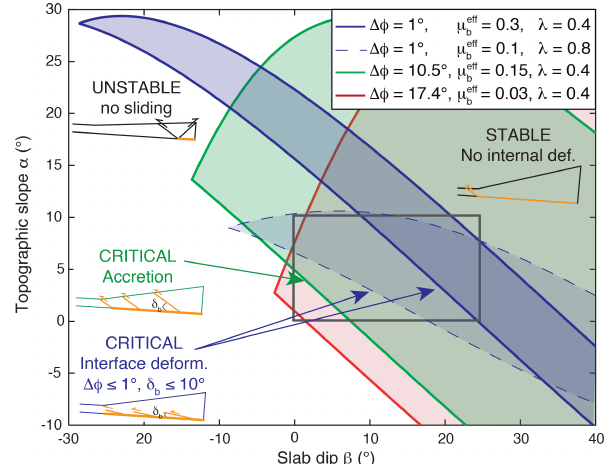
Figure 2. Critical taper theory with different mechanical states. The gray rectangle represents the standard range of topographic slope α and slab dip β of subduction zones. With extremely low effec- tive friction along the megathrust (red curve), the wedge systemat- ically falls in the stable domain. With larger effective friction, and large difference of effective friction between the megathrust and the wedge (green curve), the wedge can reach the accretionary criti- cal state characterized by internal faulting. With a reduced differ- ence (blue curves), a wedge can still reach the critical state but the dip of internal faults within the wedge will decrease and become parallel to the plate interface. High pore fluid pressure facilitates in- terface deformation for low slab dips (dashed blue curve), whereas lower pore fluid pressure induces interface deformation at larger slab dip (plain blue